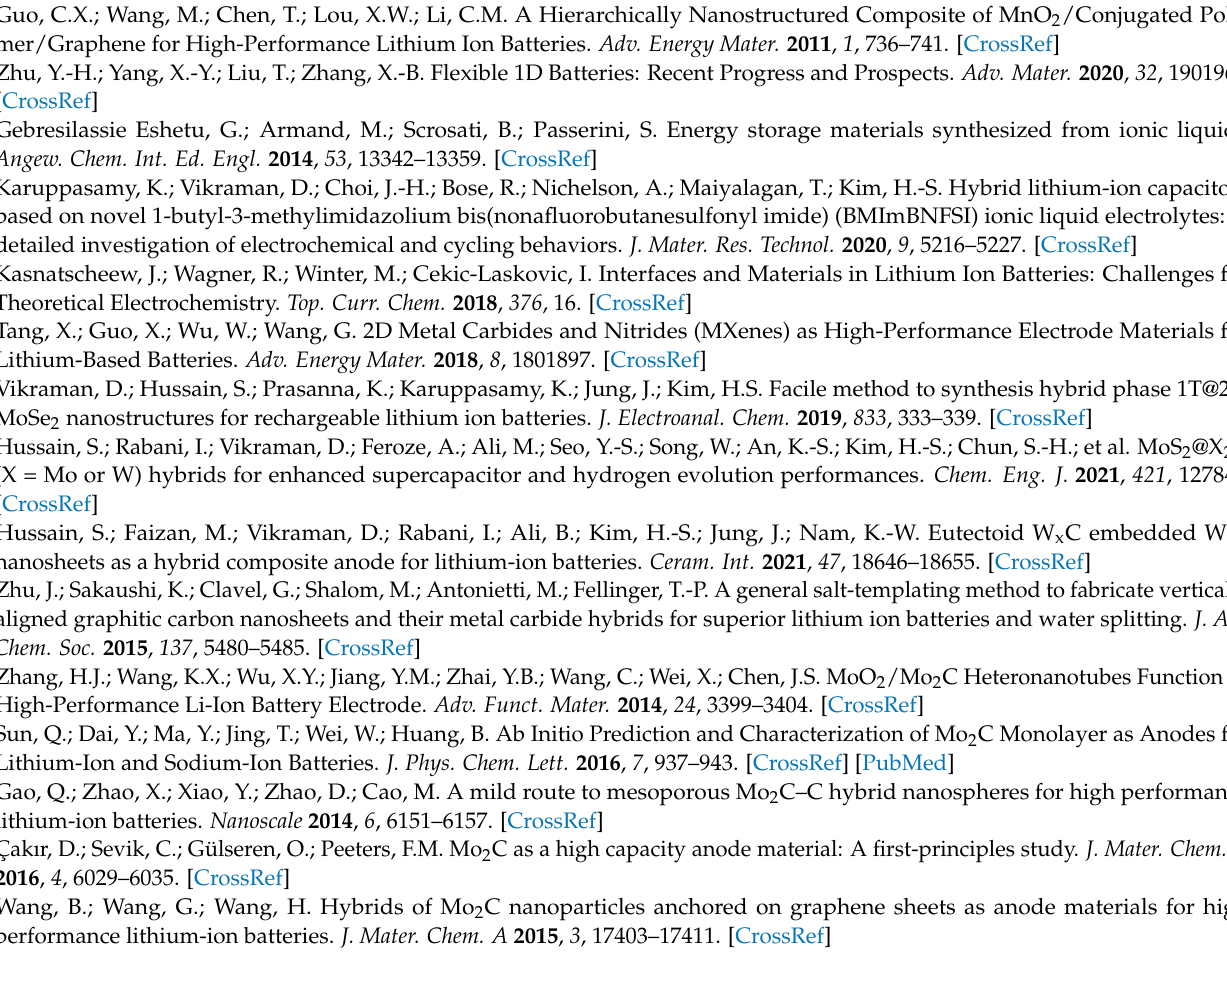
Figure S3: Nyquist plots of the CNT, Mo 2 C, and Mo 2 C@CNT hybrid anodes, Figure S4: EIS plots for the Mo 2 C@CNT anode after 1st, 50th and 100th